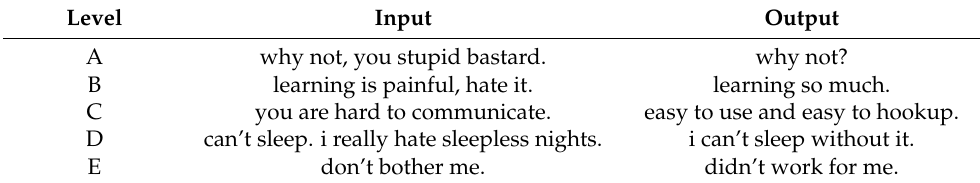
Table 8. Examples demonstrating the assessment criteria at five levels.